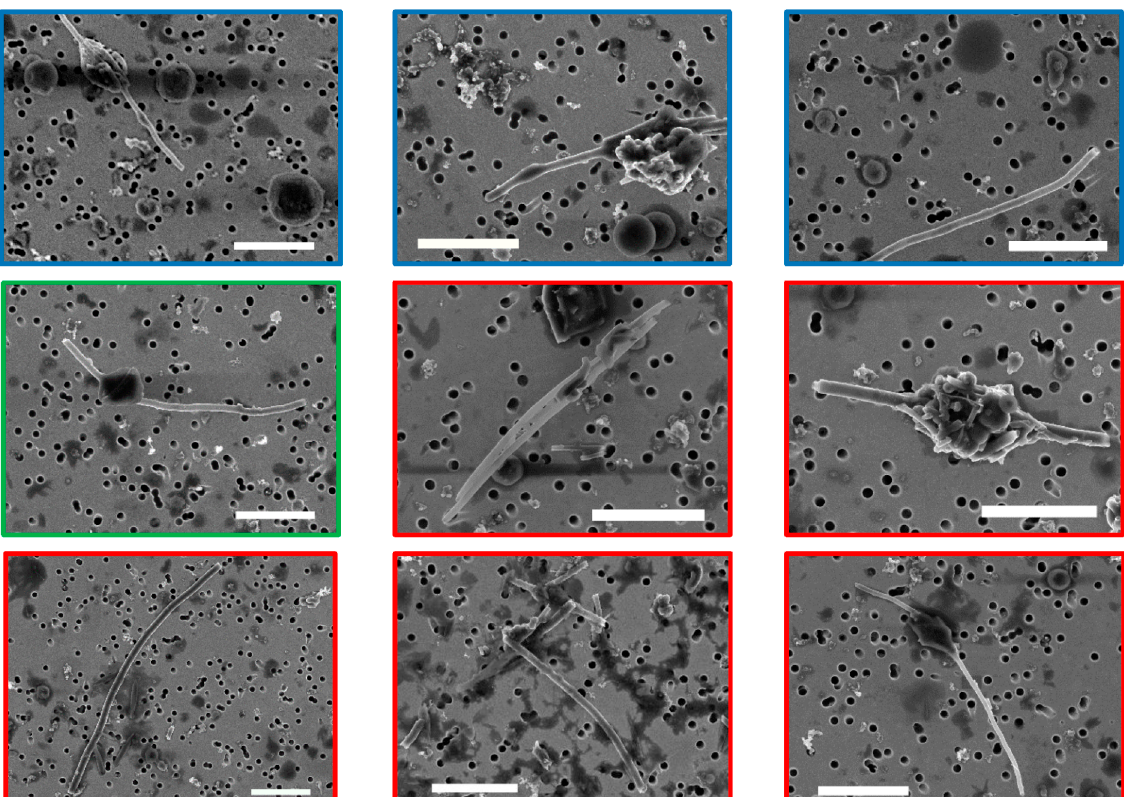
Figure 7. SEM images of all identified WHO 20 -objects of the product CNF-material found on the nearfield aerosol sample of WP02. A green frame indicates fibers that were contained in the initial image frame. A blue frame indicates non-contained fibers recognizable as WHO 20 -object. A red frame indicates fibers that required a re-addressing SEM measurement to be recognizable as WHO 20 -fibers. The center image contains two WHO 20 -fibers. A total number of ˆ N WP02,NF = 3 × 0.5 + 1.0 + 6 × 0.5 = 5.5 WHO 20 -fibers was observed. The length of the scale bars is 2 µ m.